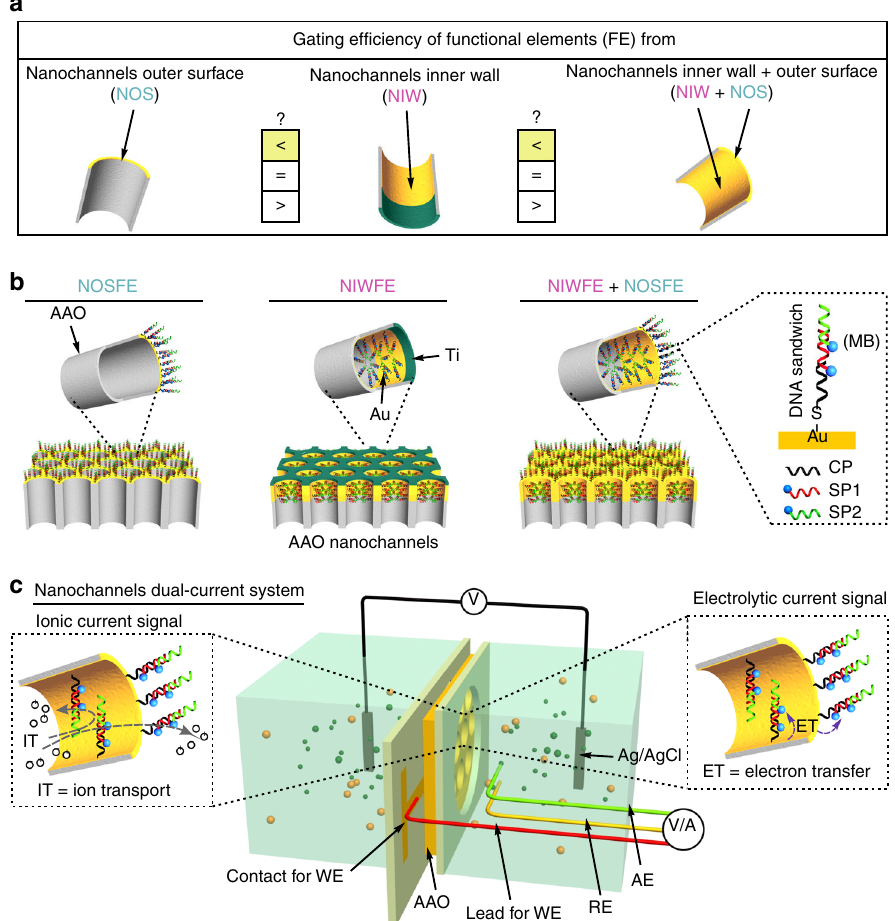
Fig. 1 Design principle and experimental setup. a Graphical illustration of nanochannels functional regions (NOS, NIW, and NIW + NOS) associated with ion-gating ef fi ciency to be investigated. b Cartoon presentation of DNA-based functional elements (FE) regionally assembled at different regions of metal- decorated AAO nanochannels. Shown inset is a DNA traditional sandwich (TS) tethered with double-MB electrochemical tags. CP capture probe, SP signal probe. c Schematic diagram of the nanochannels ’ dual-current setup. Ion transport (IT) and electron transfer (ET) through inner-wall and outer-surface DNA-functionalized nanochannels (NIWFE+ NOSFE) are schematically presented, which simultaneously generate DNA framework mediating ionic current (IC, left panel) and electrolytic current (EC, right panel) signals through a two-electrode picoammeter and a three-electrode electrochemical analyzer, respectively. WE, working electrode; AE, auxiliary electrode; RE, reference electrode. Of note, the metal-decorated AAO nanochannels ’ membrane serves as WE and is in electric touch with a conducting strip on a polymethyl methacrylate (PMMA) plate that is directly connected to the